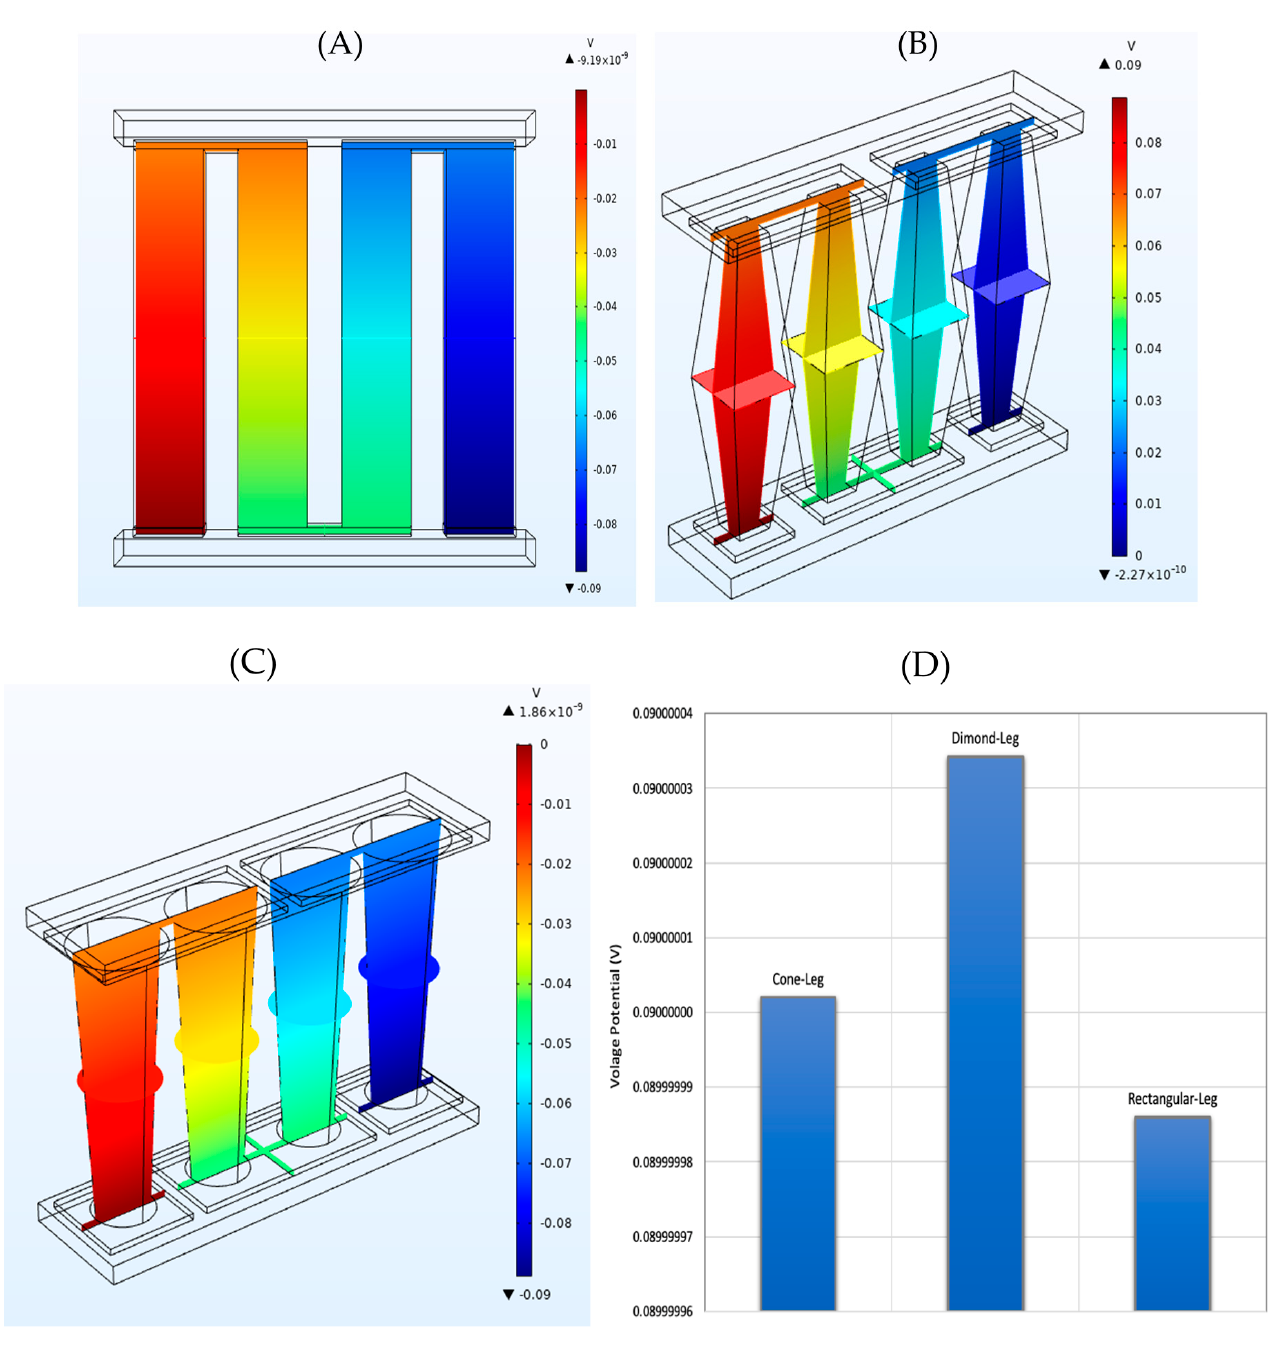
Figure 4. The electric potential produced in ( A ) Rectangular shape, ( B ) Diamond shape, ( C ) Cone shape and ( D ) Voltage Comparison.